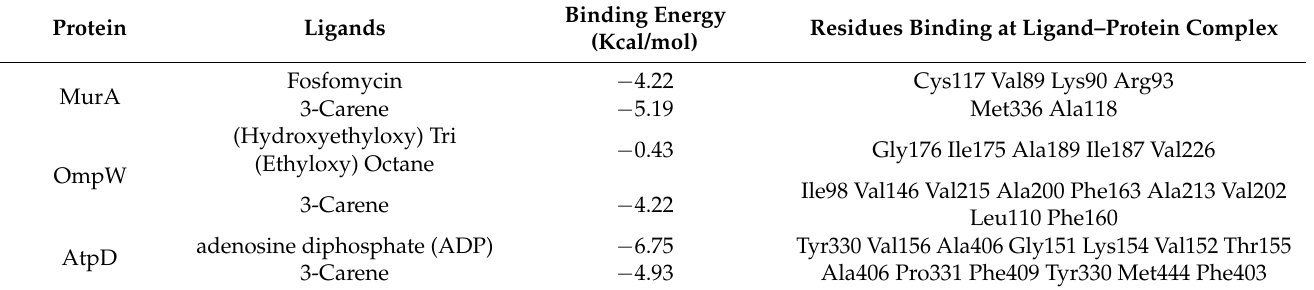
Table 5. Detailed interaction between the P. lundensis proteins and ligands.